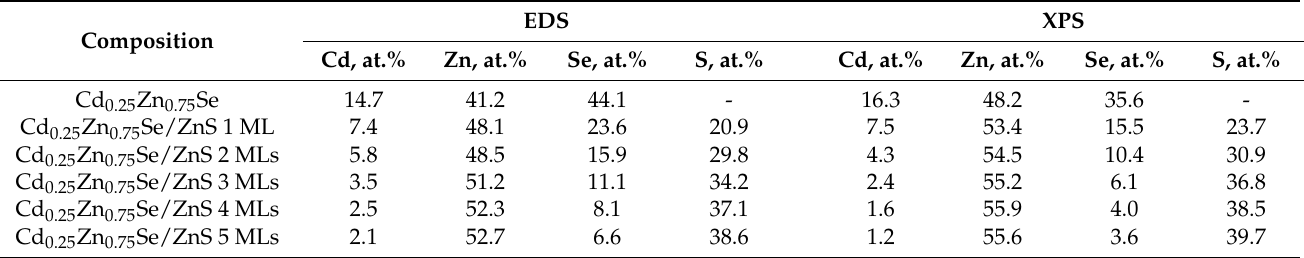
Table 1. Elemental composition of Cd 0.25 Zn 0.75 Se/ZnS core/shell QDs measured by EDS * and XPS ** technique. EDS XPS Composition Cd, at.% Zn, at.% Se, at.% S, at.% Cd, at.% Zn, at.% Se, at.% S,